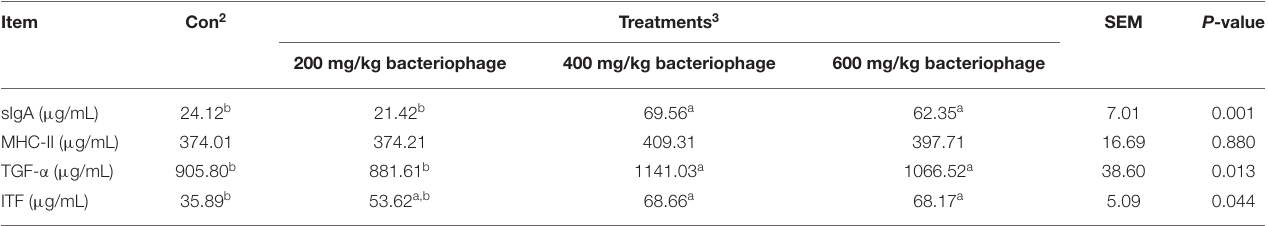
TABLE 5 | Effect of dietary bacteriophage supplementation on ileal mucosal barrier factors of piglets fed antibiotic-free diet ( n = 5) 1 .